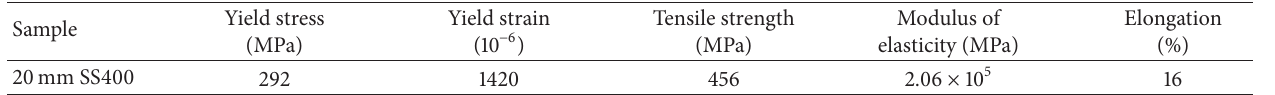
Table 1: Tensile test results.